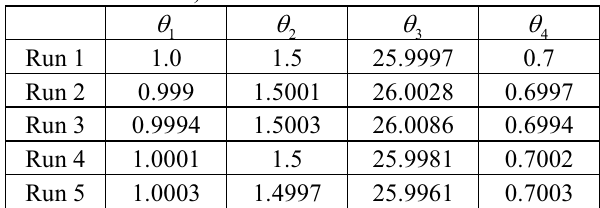
Tab. 2 Numerical results for the first five runs (Run 1~Run